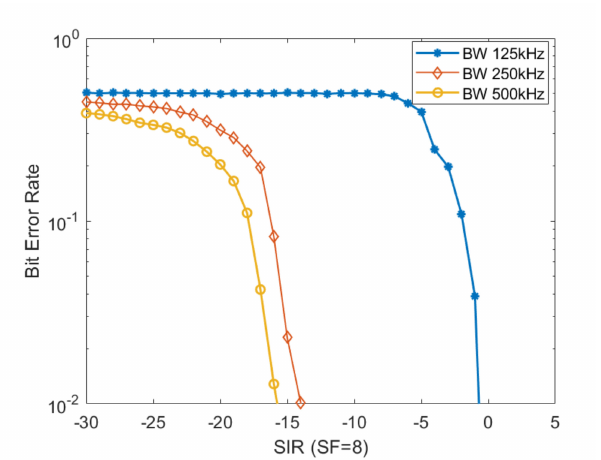
Figure 7. BER curves for a specific SF obtained by varying the BW size from 125 kHz to 250 kHz and 500 kHz, respectively, while maintaining the same payload size 120